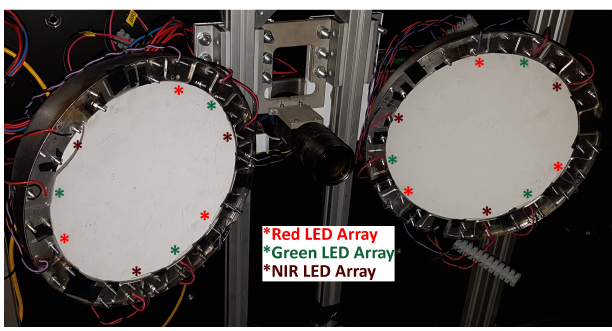
Figure 2. Illumination system containing nine LED arrays per lamp, positioned at regular